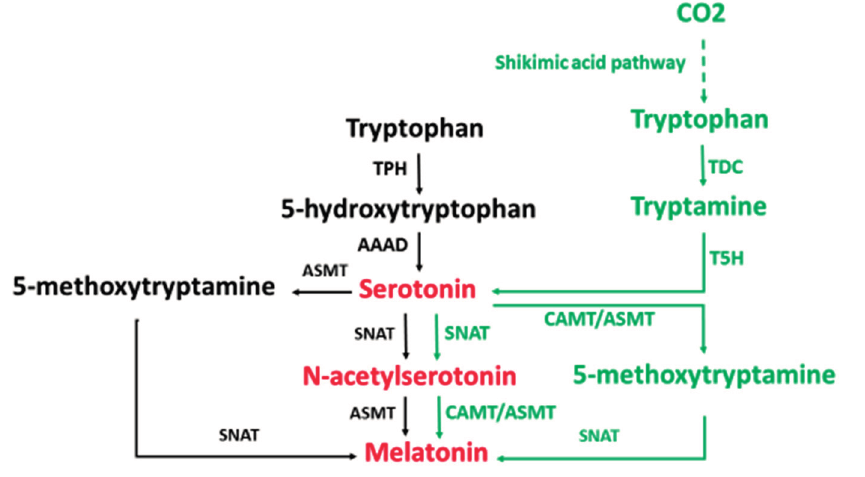
Figure 1. A comparison of the biosynthetic pathways of melatonin in animals and in plants. TPH: tryptophan hydroxylase; AAAD: aromatic amino acid decarboxylase; SNAT: serotonin N -acetyltransferase; ASMT: N -acetylserotonin O -methyltransferase, TDC: tryptophan decarboxylase; T5H: tryptamine 5-hydroxylase, CAMT: caffeic acid O